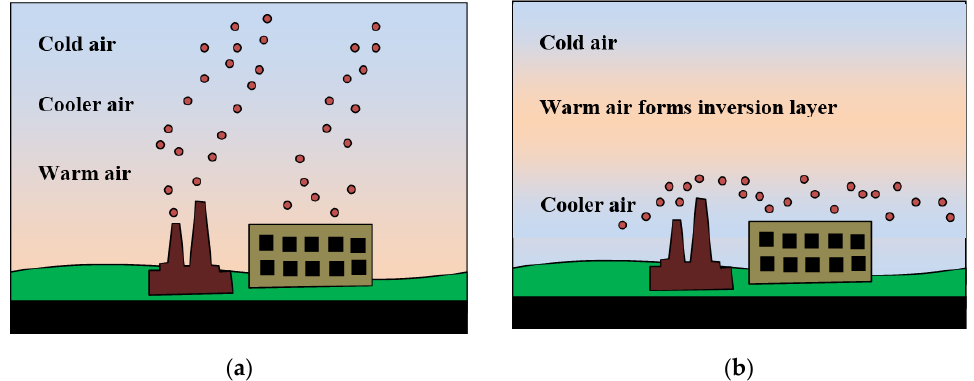
Figure 1. Temperature inversion. ( a ) Normal aerosol convection; ( b ) inhibited aerosol convection under the warm air inversion layer.